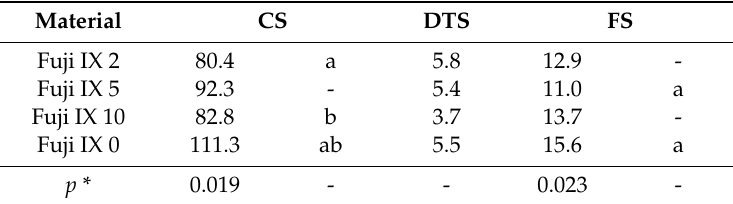
Table 6. Results of the ANOVA test for Fuji